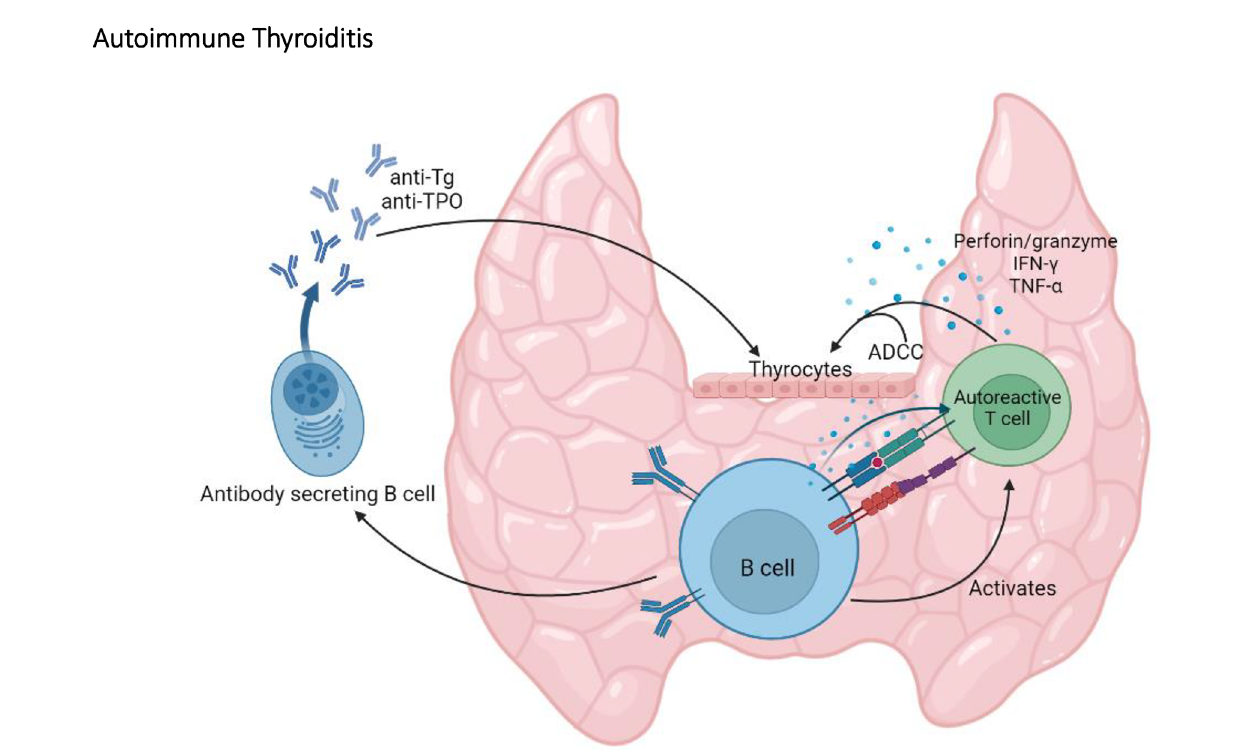
FIGURE 3 | The central role of B cells in autoimmune thyroiditis. By producing anti-thyroglobulin (Tg) and anti-TPO autoantibodies, by activating autoreactive T cells, and by promoting antibody dependent cell cytotoxicity (ADCC), B cells play an important role in the onset and the progression of autoimmune thyroiditis in the NOD